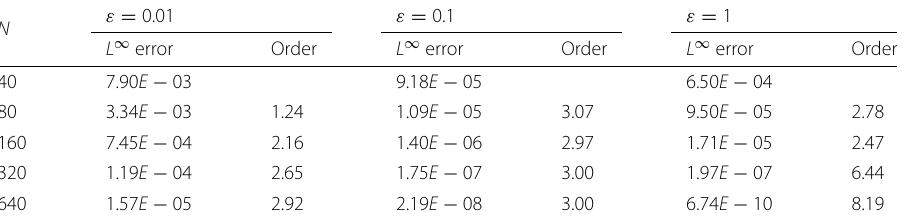
Table 3 Example 1. L ∞ errors and numerical orders of temporal accuracy obtained with the SA IMEX-ARS3 WCNS at t = 0.1